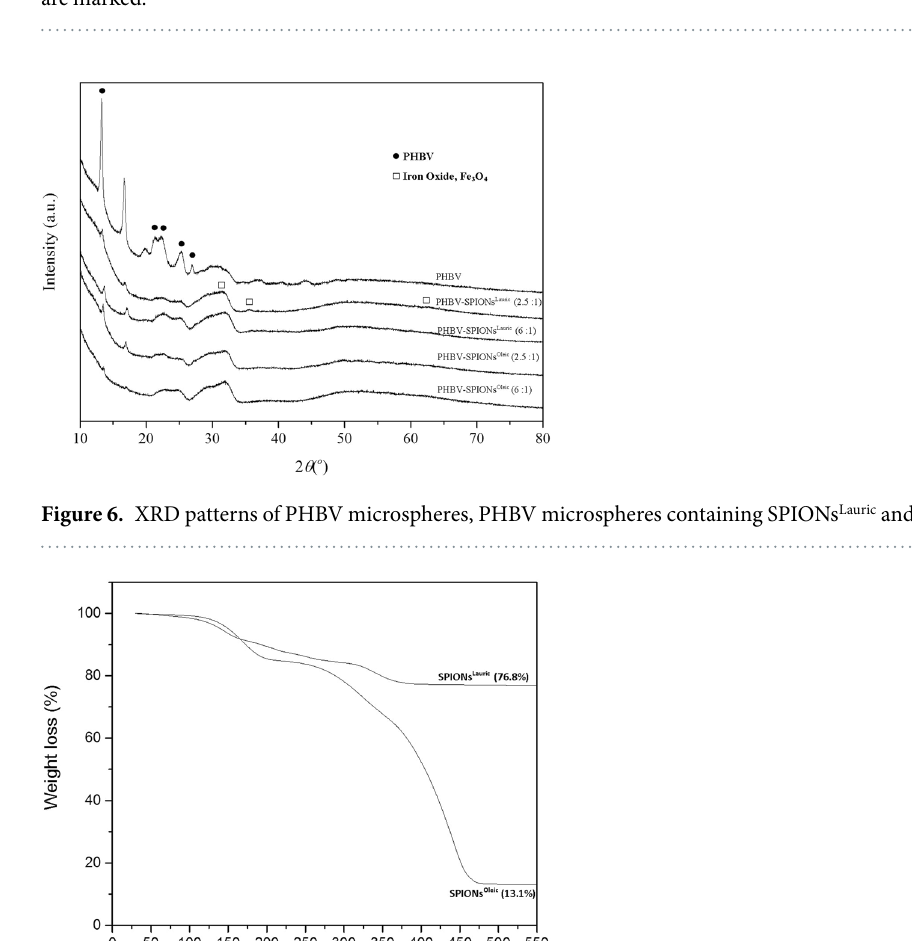
Figure 5. XRD patterns of uncoated SPIONs, SPIONs Lauric and SPIONs Oleic . The characteristic peaks of Fe 3 O 4 are marked.